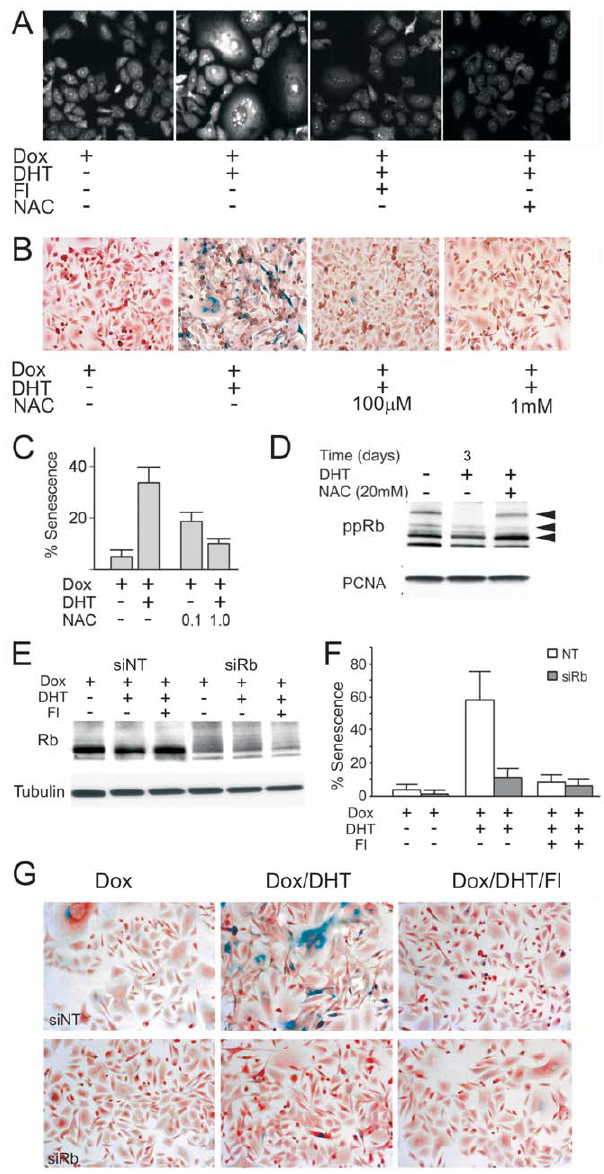
Figure 4. AR-induced senescence requires ROS and Rb. This figure depicts the role of ROS and RB in AR-dependent senescence. ( A ). PC3-AR cells were treated with Dox, DHT and Fl, as indicated and ROS assessed by DHE fluorescence. Note increased ROS upon DHT treatment and lower DHE fluorescence in the presence of Fl (20 m M). ROS quencher, NAC (10 mM) was used as a negative control. ( B, C ) The effect of NAC on AR-induced senescence: PC3-AR cells were cultured in Dox, AR activated with DHT 6 NAC, and senescent cells visualized with SA- b Gal assay. Representative images (B) and quantitative assessment (C) are shown. ( D ) PC3-AR cells were cultured in Dox, treated 24 hours with DHT and/or NAC (20 mM) where indicated. Cell extracts were analyzed by western blot for phospho-Rb. PCNA was used to assess loading. Note increased Rb phosphorylation in the presence of NAC. ( E ) PC3-AR cells were transfected with Rb siRNA and Rb levels measured after 24 hours by western blot. Note , 2-fold reduction after transfection with Rb siRNA. ( F, G ) S enescence was measured by SA- b Gal assay on day 6 after Rb knock-down (values calculated as in Fig. 1, S.D. values are shown; P , 0.0002). Note the reduced senescence of the DHT-treated cells after Rb knock-down. Representative images are shown below